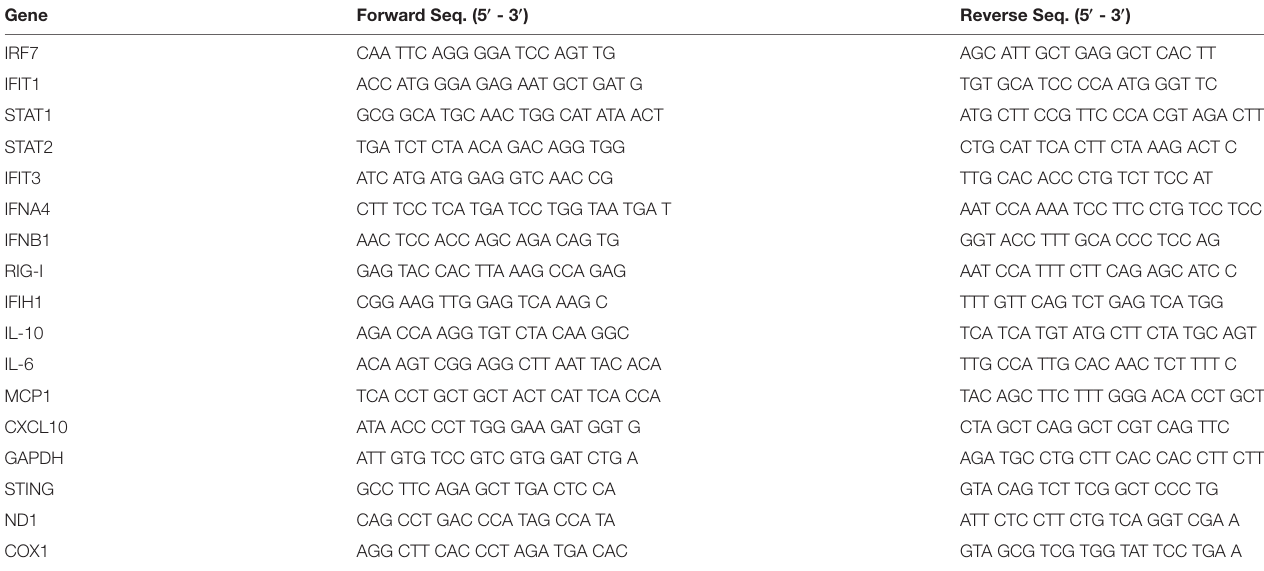
TABLE 1 | qPCR primers used in experiments. Gene Forward Seq. (5 (cid:48) - 3 (cid:48) ) Reverse Seq. (5 (cid:48) - 3 (cid:48)